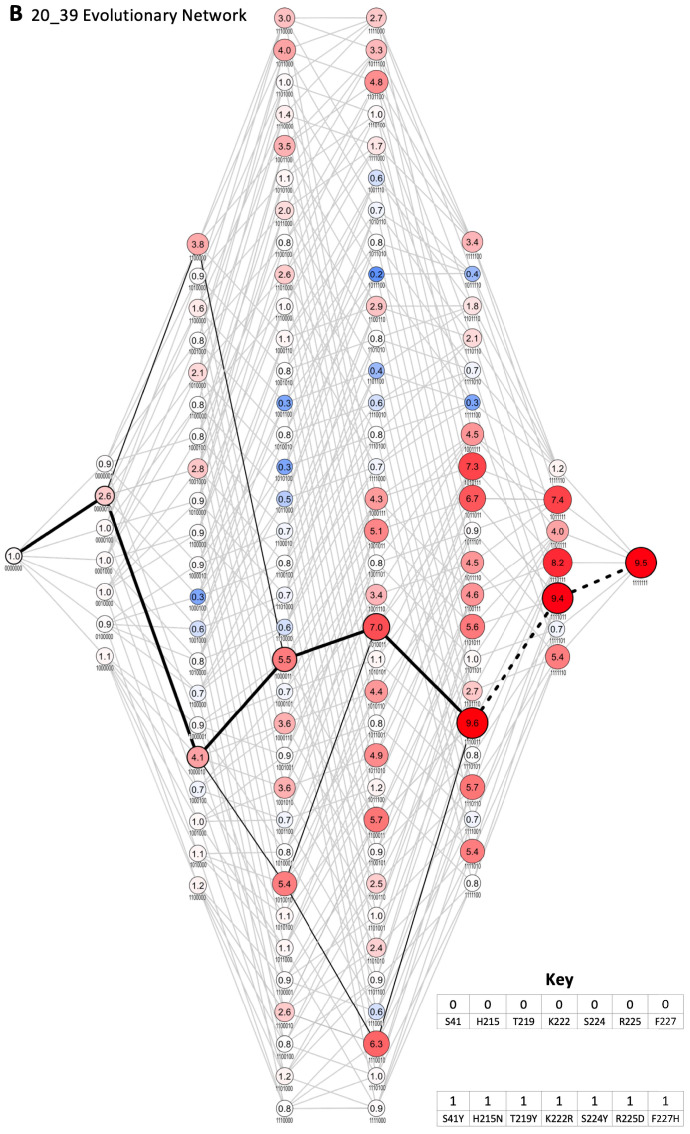
Evolutionary network of 20_39.Each node represents an enzyme intermediate, with the substitutions present in the intermediate indicated by the presence (1) or absence (0) of the substitutions S41Y, H215N, T219Y, K222R, S224Y, R225D, and F227H, respectively. The numbers within each node represent the fold activity relative to wild-type NfsA measured in E. coli EC50 assays; to facilitate rapid evaluation, the fold-activity for each node is also represented by the area of the circle, and by a colour-code (progressively less activity than wild-type NfsA in brighter shades of blue, and progressively more activity than wild-type NfsA in brighter shades of red). All 5040 possible evolutionary trajectories are marked by grey connecting lines. If a substitution resulted in a ≥ 16% increase in activity, the edge connecting the two nodes is shown in black (16% being greater than the average error for each set of 128 intermediates). The most probable stepwise mutagenesis pathway (shown in Figure 2F) is shown as thick black lines. A dotted line indicates that a substitution did not result in a ≥ 16% increase in activity, but formed part of the most probable stepwise mutagenesis evolutionary trajectory.